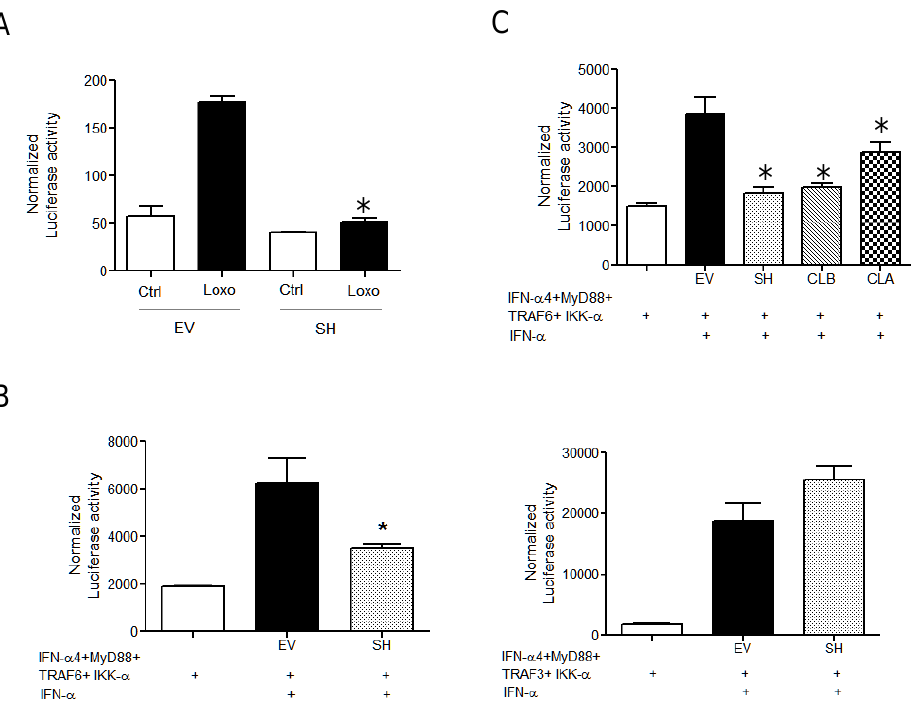
Figure 3. hMPV SH protein inhibits TLR7-dependent signaling. ( A ) 293 cells stably expressing TLR 7 were co-transfected with an IRF-driven promoter and either the SH expression plasmid (1 g) or its empty vector (EV) and stimulated with 1 mM loxorabine. Cells were lysed 40 h post-transfection to measure luciferase activity. ( B ) 293 cells were co-transfected with IFN- α 4 promoter (0.1 g), linked to a luciferase reporter gene together with MyD88 (0.1 g), IKK- α (0.1 g), and TRAF6 (0.5 g) ( left panel ) or TRAF3 (0.5 g) ( right panel ) expression plasmids in the presence of SH expression plasmid (1 g), or its empty vector (EV). Cells were treated with recombinant IFN- α (100 µ g/mL), to activate TLR7, and harvested 40 h later to measure luciferase activity. ( C ) 293 cells were co-transfected as described in panel B with TRAF6 and a plasmid expressing the SH protein isolated from a representative clinical isolate A (CLA) or B (CLB). Cells were harvested 40 h later to measure luciferase activity. Data are representative of three independent experiments run in triplicate and are expressed as means ± SEM of normalized luciferase activity to the β -galactosidase reporter activity. * p < 0.05 relative to the empty